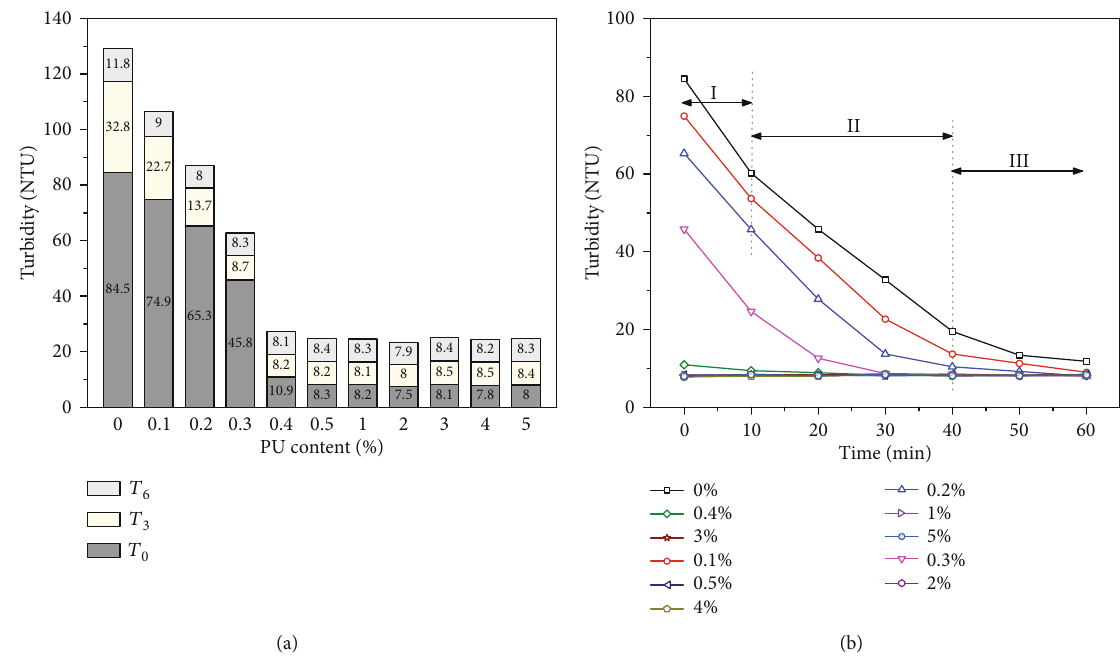
Figure 7: (a) The e ff ect of PU content on the turbidity; (b) the relationship between the turbidity and the time.